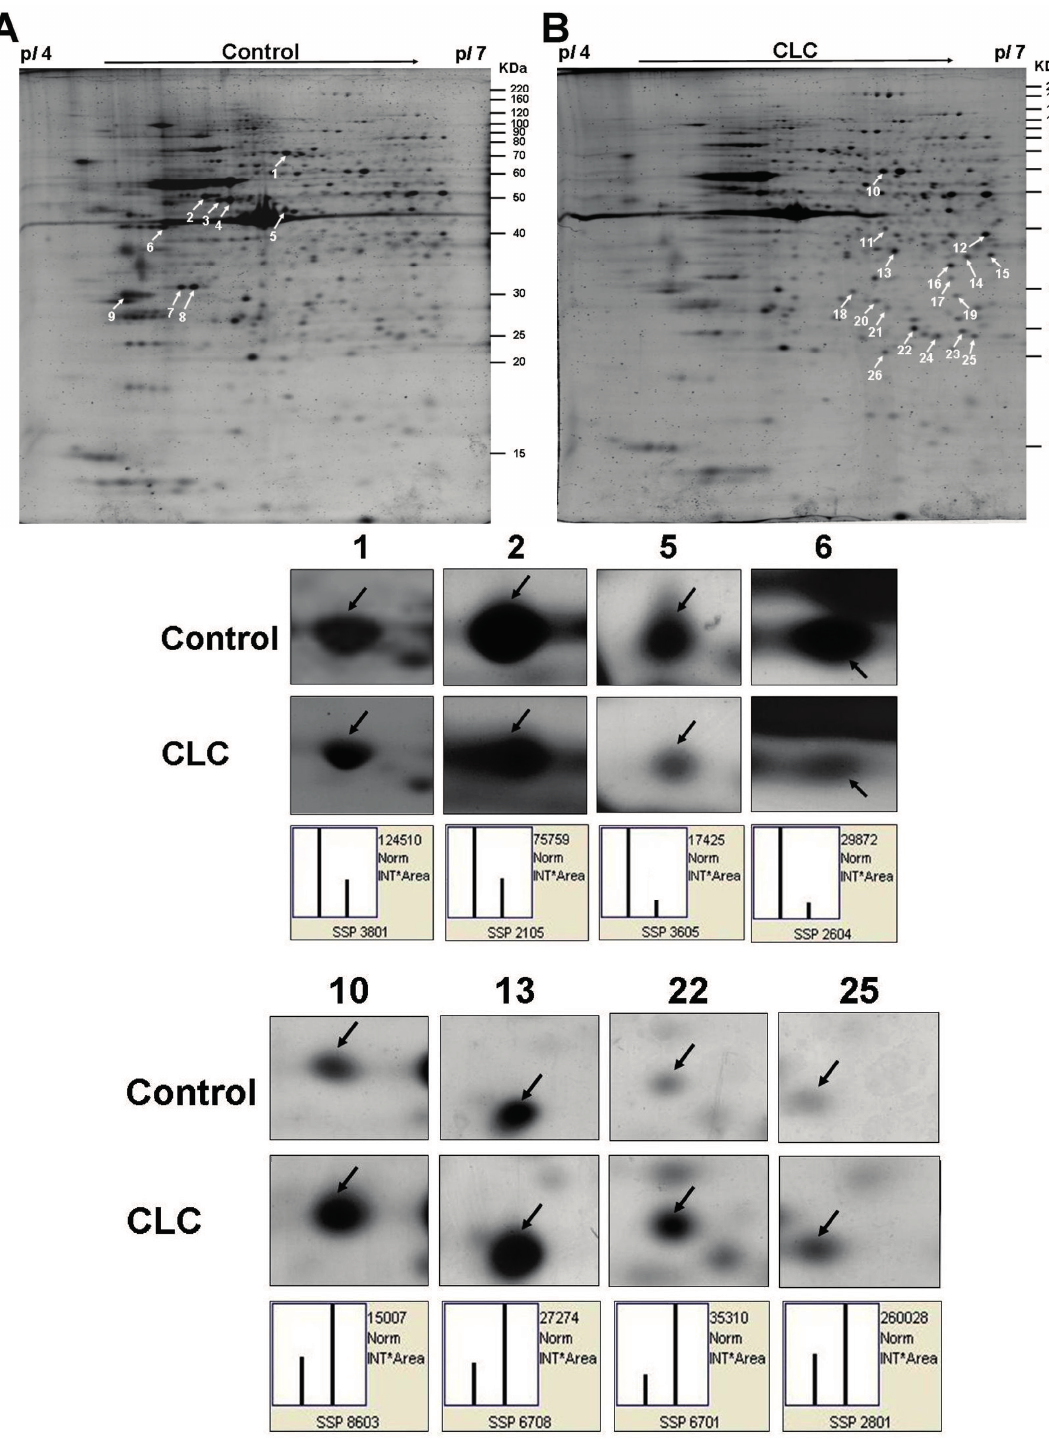
Figure 3. Computed image analysis of Sypro-ruby stained 2-DE gels. ( A ) The proteomic signature of DPCs; ( B ) The proteomic signature of DPCs treated with 2 µM CLC for 6 h. The magnified images of four down-regulated and four up-regulated protein spots were also shown below the 2-DE gels, respectively. White arrows indicated the positions of identified proteins on 2-DE gels. The standard spot (SSP) number was the number attributed to each protein spot by PDQuest software. Each SSP number uniquely identified that